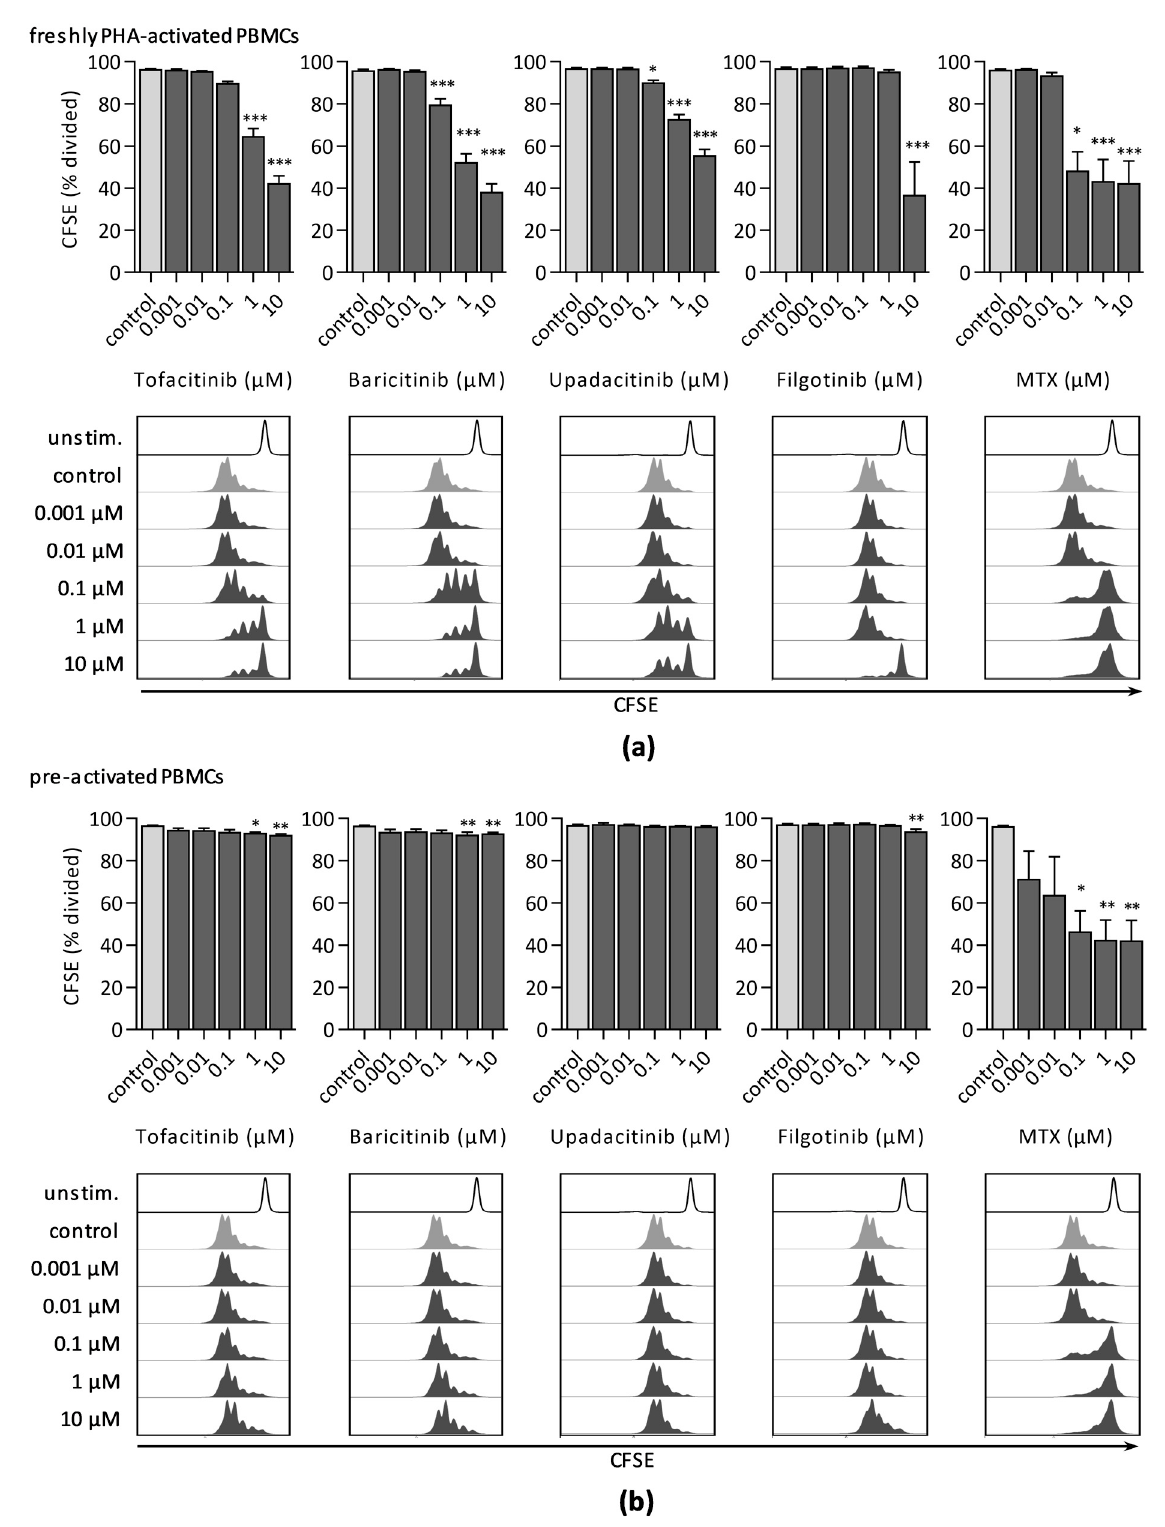
Figure 2. Proliferation analysis by CFSE dilution assay 96 h after PHA-stimulation of PBMCs treated with indicated concentrations of JAKi or MTX either ( a ) immediately after activation or ( b ) 48 h after PHA-stimulation. Percentage of divided cell population was quantified. Diagrams display the mean ± SEM of three independent experiments (*** p ≤ 0.001; ** p ≤ 0.01; * p ≤ 0.05). Representative histograms of CFSE intensity are shown below.